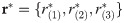
A graphical model representation of our phylo-HMM for an example alignment with m = 3 sequences and n = 3 sites.The τ, t, π, and e nodes represent the 4-tip unrooted tree topology, the associated 5 branch lengths, the GTR exchangeability rates, and GTR equilibrium base frequencies, respectively. The parameter α denotes the gamma shape parameter associated with the K-class discrete gamma distribution, which is used to model phylogenetic rate variation among sites; r symbolizes the vector of K discrete rates that is deterministically induced by α. The set of nodes r*={r(1)*,r(2)*,r(3)*} defines the rates that are drawn from r at each particular site. The Ynaive={Ynaive(1),Ynaive(2),Ynaive(3)} “hidden state” node collection represents the Markov process that stochastically generates the naive sequence in our phylo-HMM. The node sets {Yi(j)}i=1:2,j=1:3 and D={Di(j)}i=1:3,j=1:3 denote the internal nodes of τ excluding the naive sequence Ynaive and the observed MSA, respectively. We draw plates around the Yint(j) and D(j) node sets for j ∈ {1, 2, 3} to indicate that any directed edges touching a plate apply to all nodes in the plate (except for edges that originate from t, which apply element-wise to the nodes in the plate).